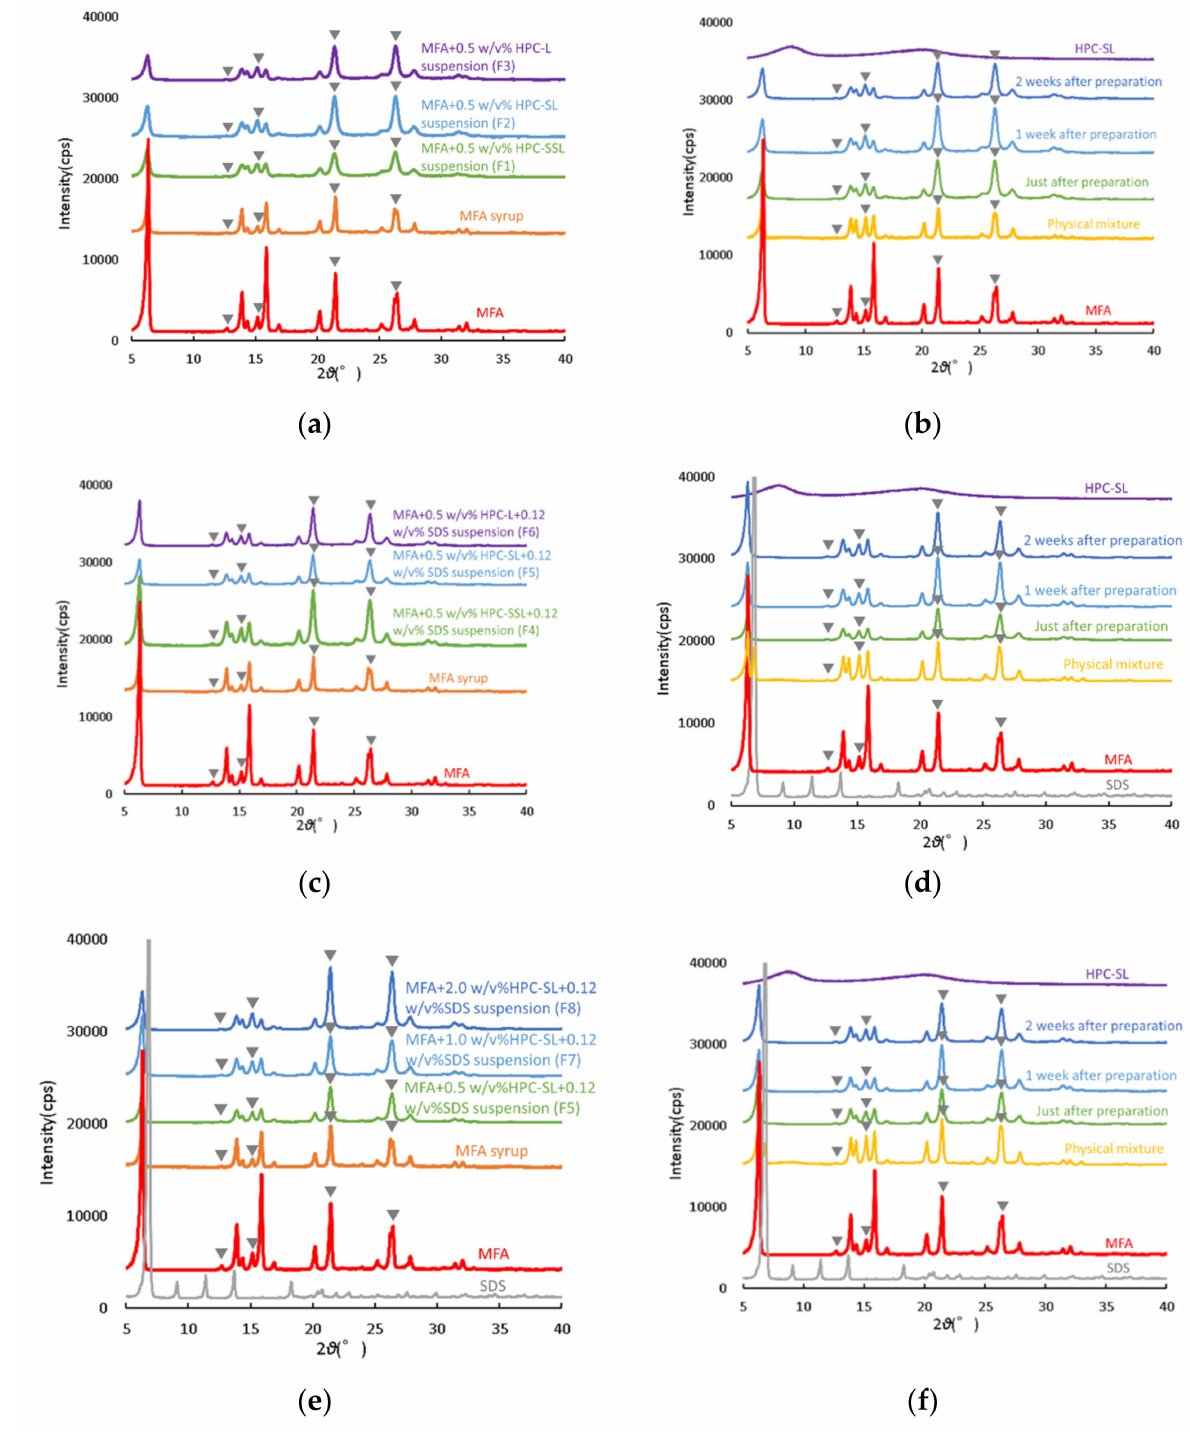
Figure 4. PXRD patterns of various samples: ( a ) F1–F3 just after the preparation; ( b ) MFA particles over time of F2; ( c ) MFA particles just after the preparation of F4–F6; ( d ) MFA particles just after the preparation of F5; ( e ) MFA particles just after the preparation of F5, F7, and F8; ( f ) MFA particle peaks over time in